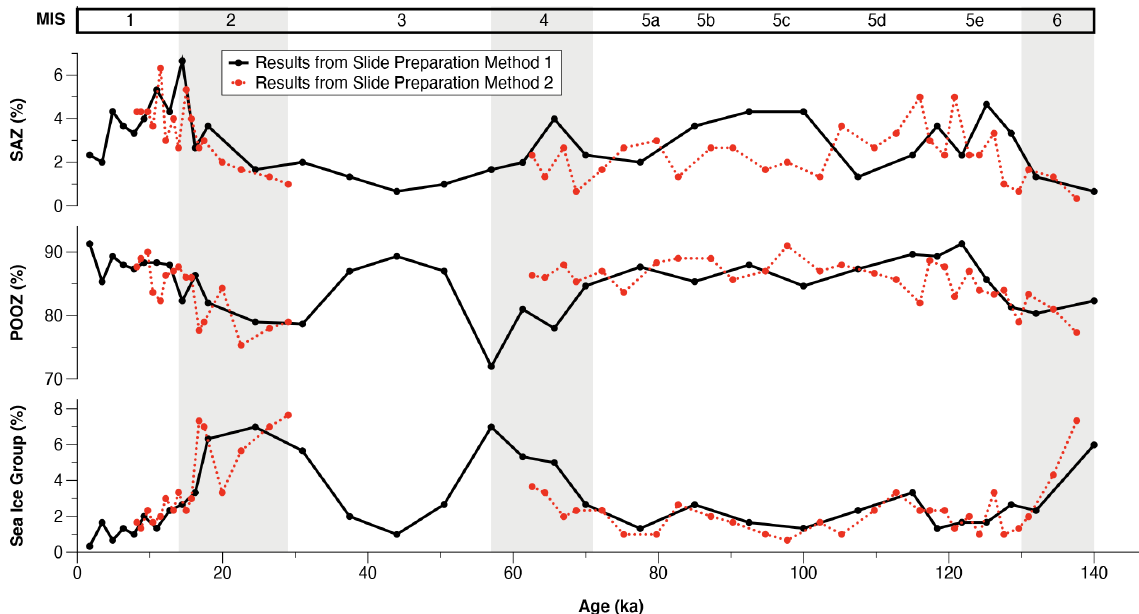
Figure B1. Results from diatom slide preparation methods 1 and 2. No notable differences or biases were observed between the two different